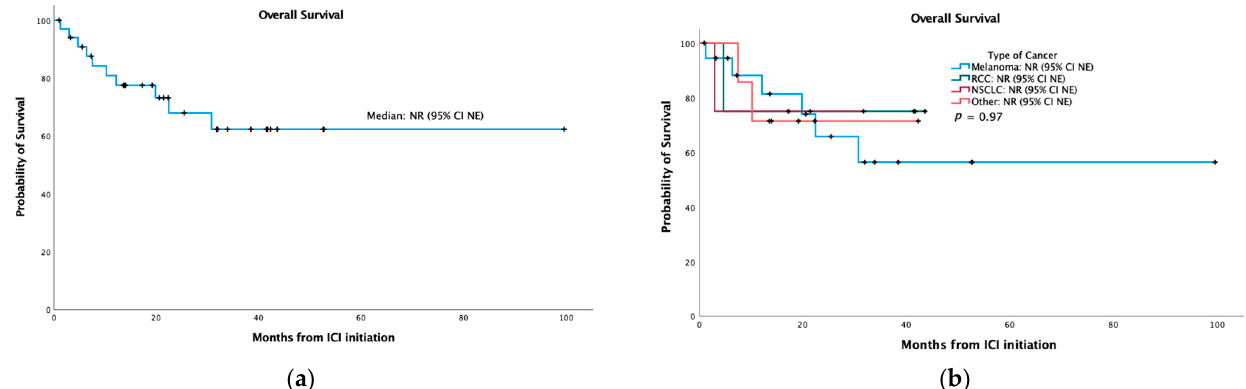
Figure 2. Kaplan–Meier curves for overall survival: ( a ) in the overall population; ( b ) stratified by primary tumor type. ICI: immune checkpoint inhibitor; NE: non-estimable; NR: not reached; NSCLC: non-small cell lung cancer; RCC: renal cell carcinoma.